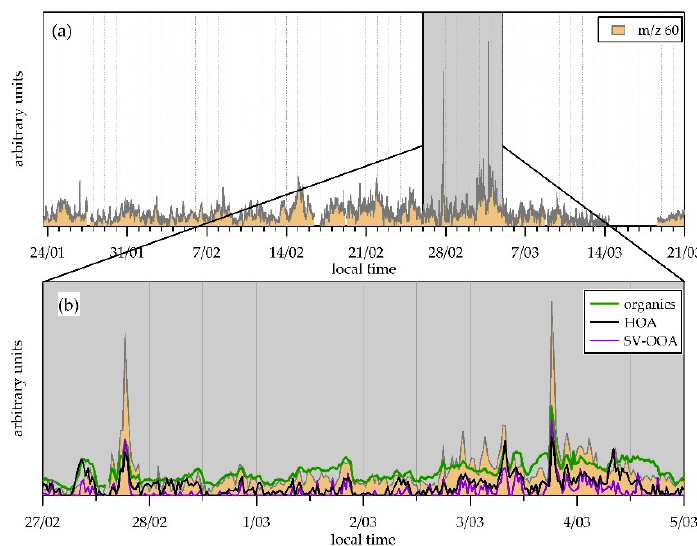
Figure 9. ( a ) Time series of the signal of ion m / z 60 during ACU15. ( b ) Times series of the signal of ion m / z 60, organics in NR-PM 1 , and hydrocarbon-like organic aerosol (HOA) and semi-volatile oxygenated organic aerosol (SV-OOA) PMF factors from 27 February to 5 March. All signals are scaled arbitrarily.